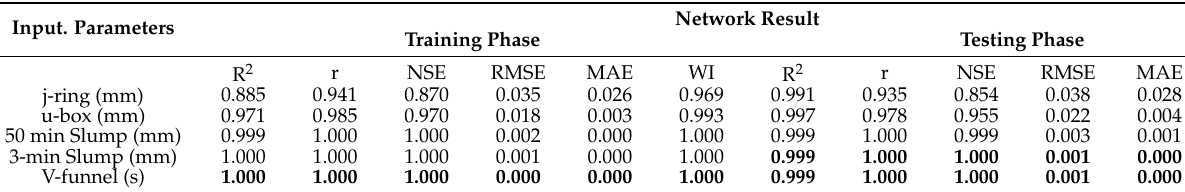
Table 8. Details of the input and output variables.